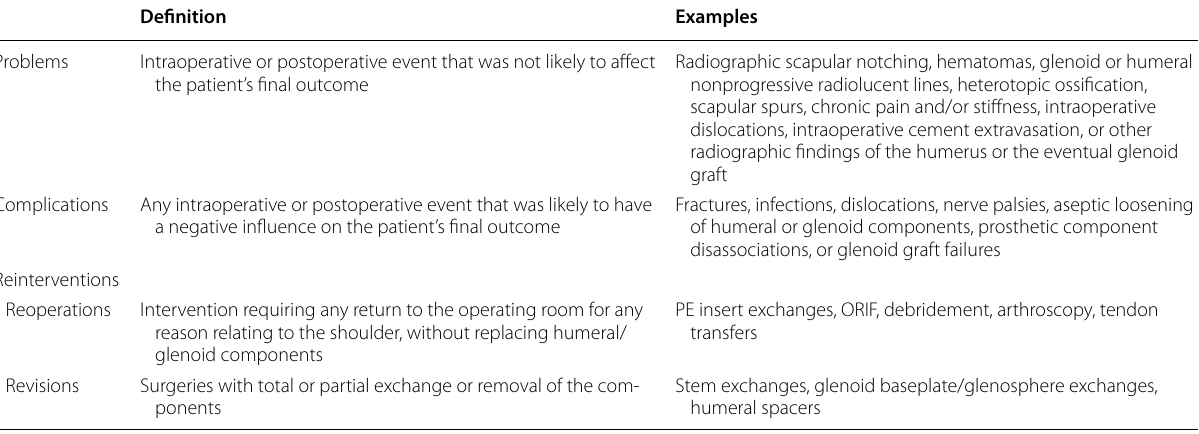
PE polyethylene insert; ORIF open reduction internal